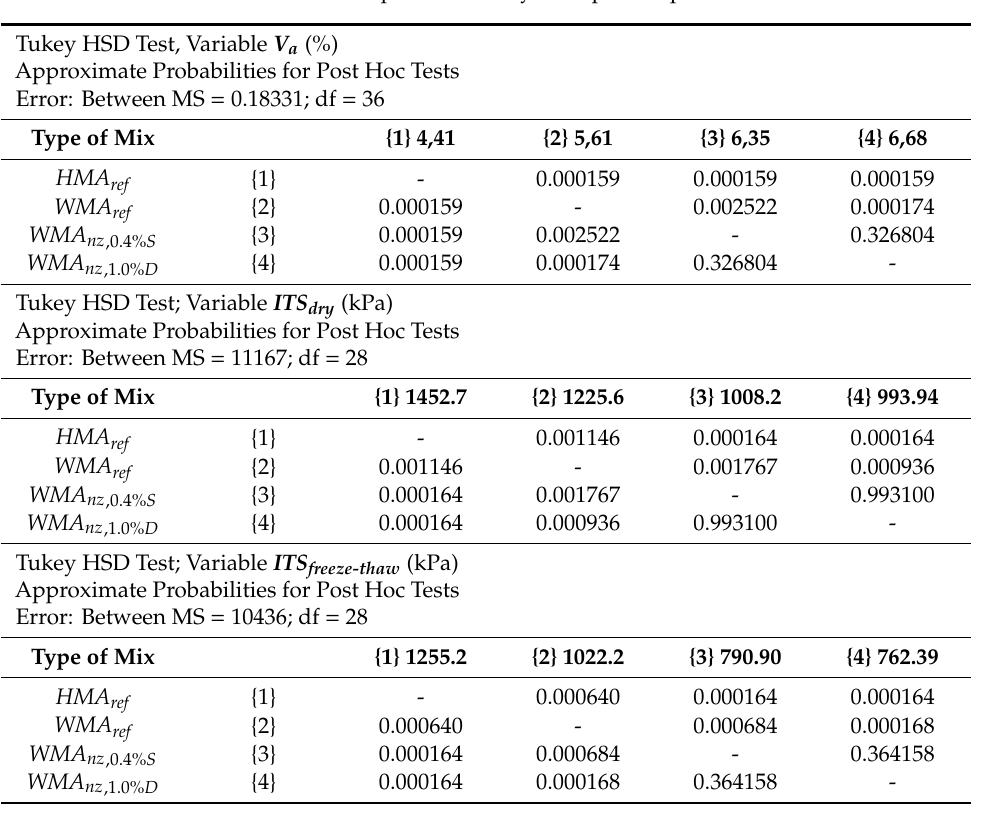
Table 15. Results of post-hoc Tukey multiple comparison